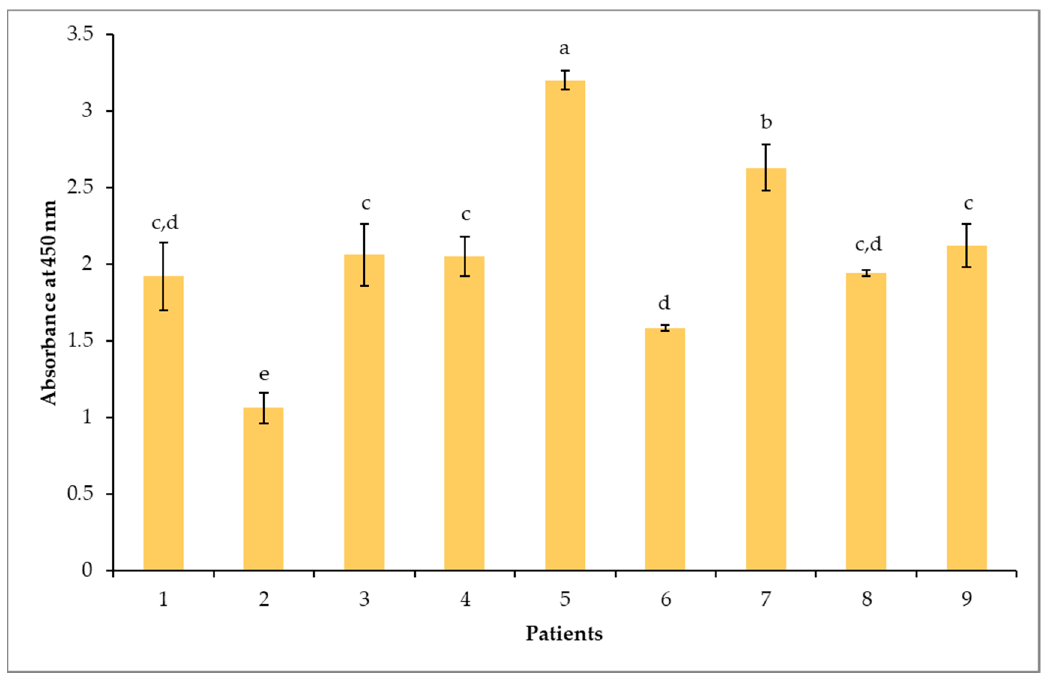
Figure 2. Indirect ELISA analysis of specific immunoglobulin E (IgE)-binding to the raw peanut extract for each individual patient. Different letters represent statistical differences according to Tukey’s test, with a confidence level of 95%. Values represent means ± SD ( n = 3).